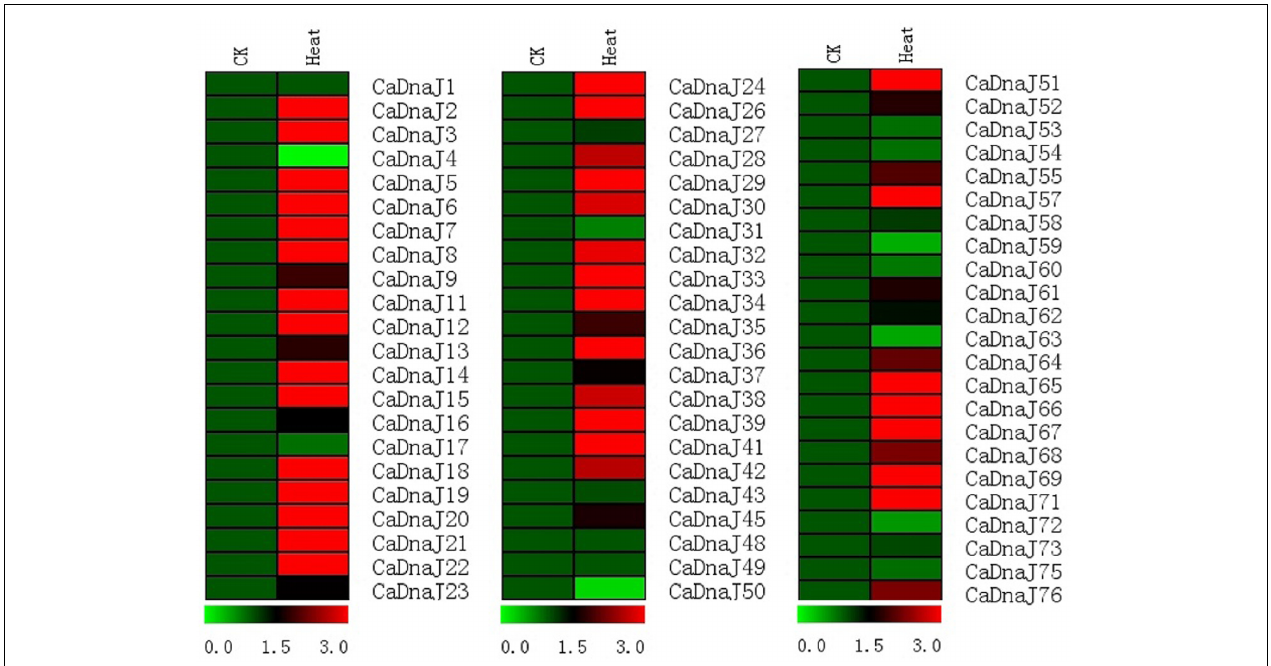
FIGURE 4 | Gene expression profiles of CaDnaJ genes in response to heat stress treatment. The expression levels of these CaDnaJs under high temperature stress treatment were tested using qRT-PCR. Green, black, and red elements indicate low, regular, and high signal intensity,